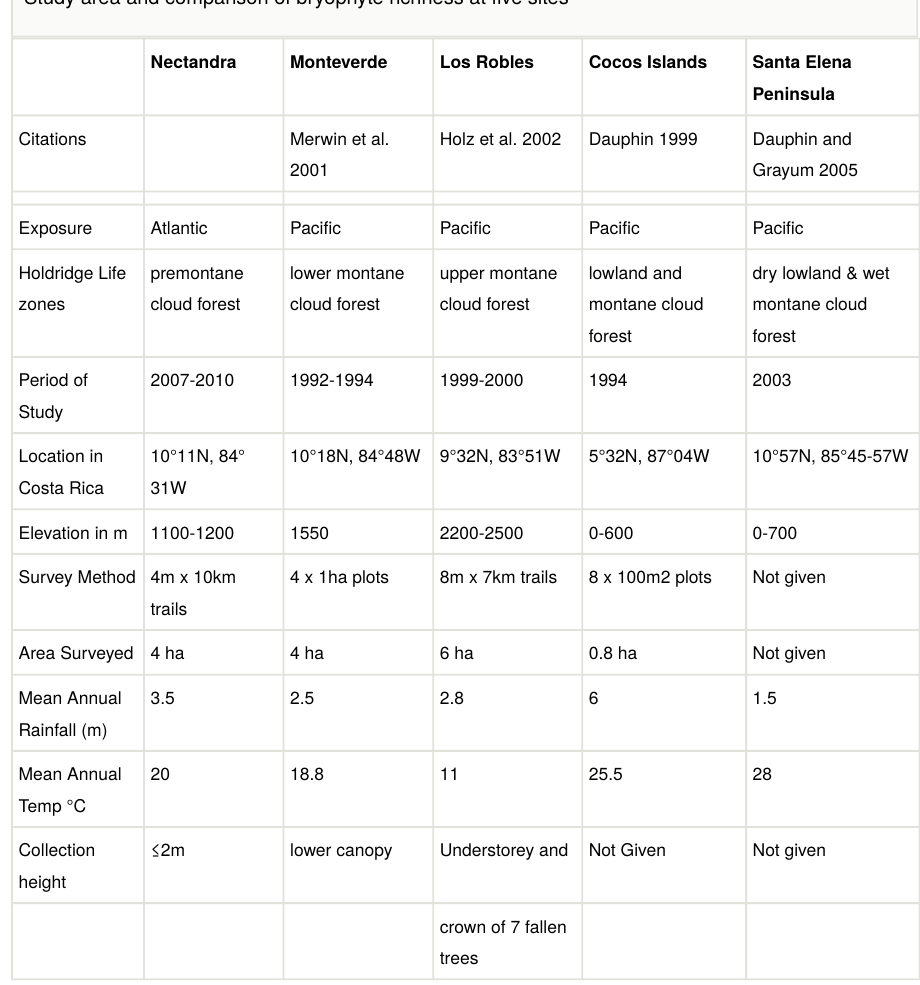
Table 2. Study area and comparison of bryophyte richness at fi ve